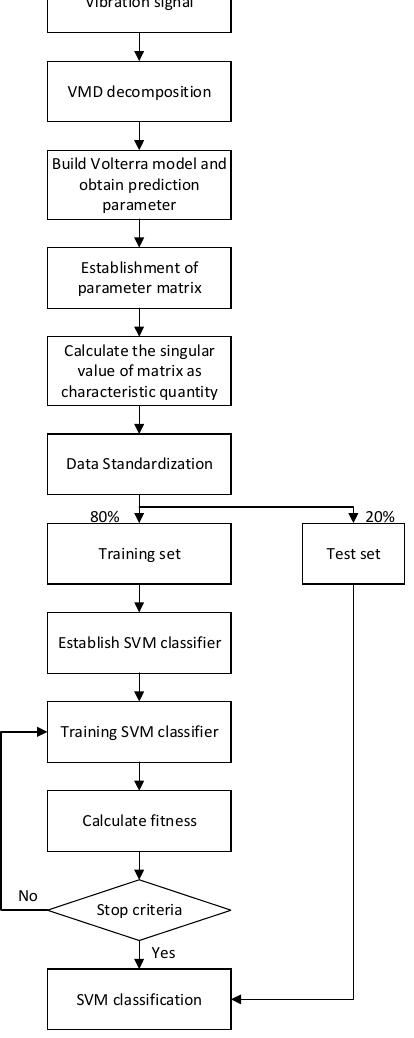
Figure 1. The VMD-Volterra-SVM flow chart.